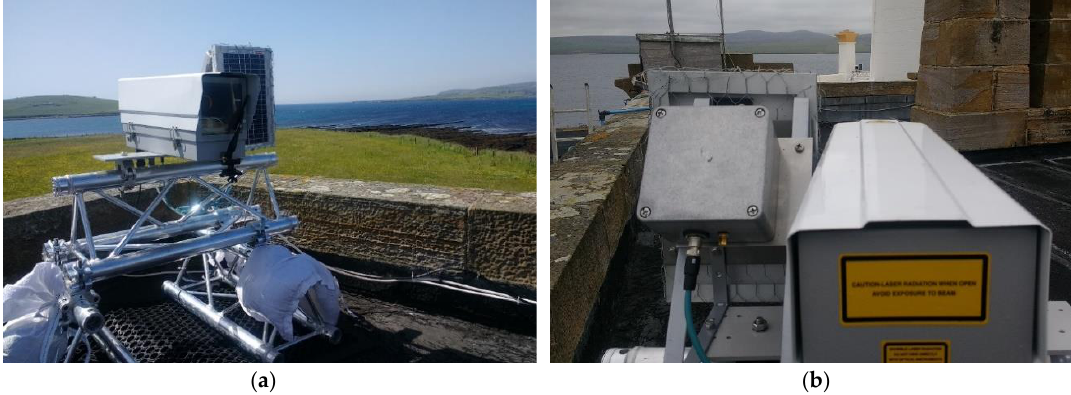
Figure 16. Installation at the location ( a ) residence property; ( b ) residence property to the lighthouse.